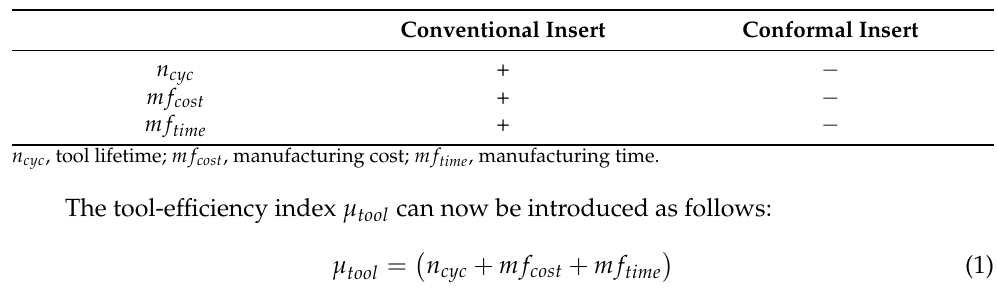
Table 4. Conventional and conformal tool performance comparison.